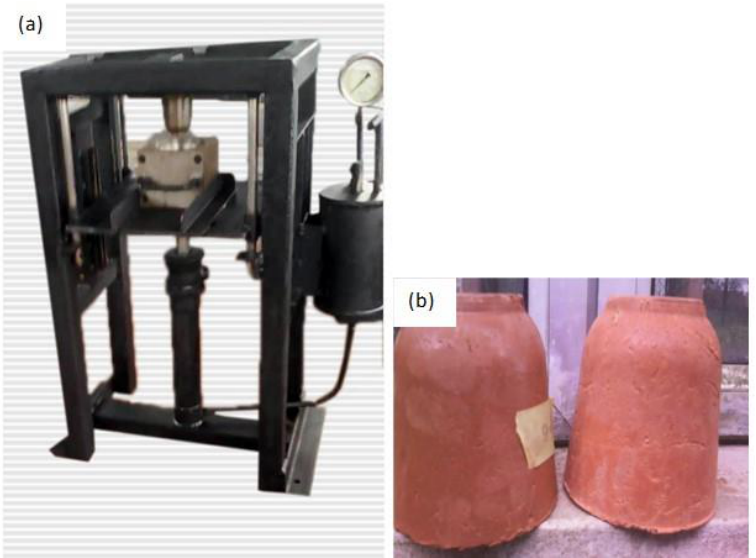
Fig.11. (a) fabricated hydraulic press machine, (b)